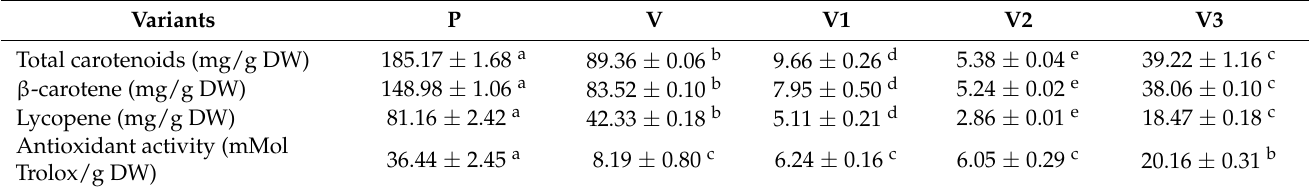
Table 2. Phytochemical profile and antioxidant activity by DPPH assay of jellified